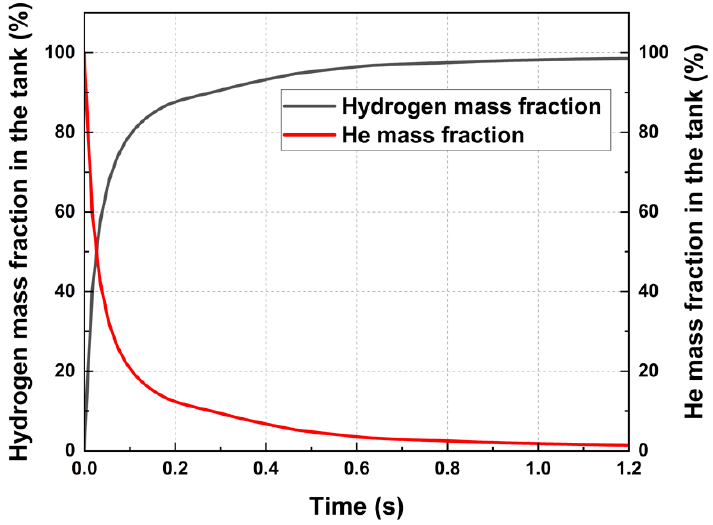
Figure 9. Variation in the mass fraction in the tank according to charging process.